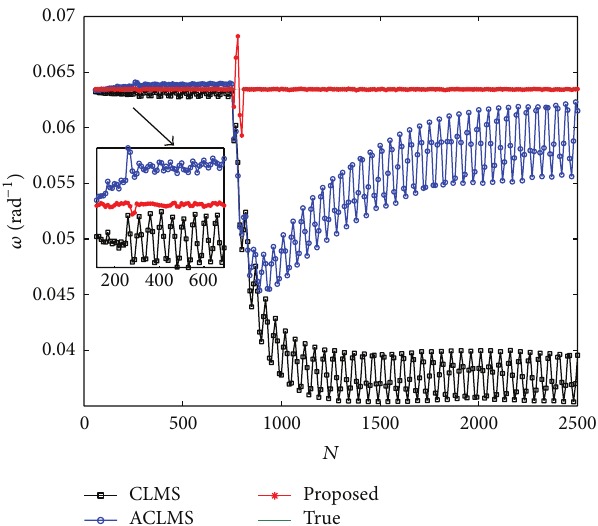
Figure 6: Mean estimated frequency versus 𝑁 under amplitude